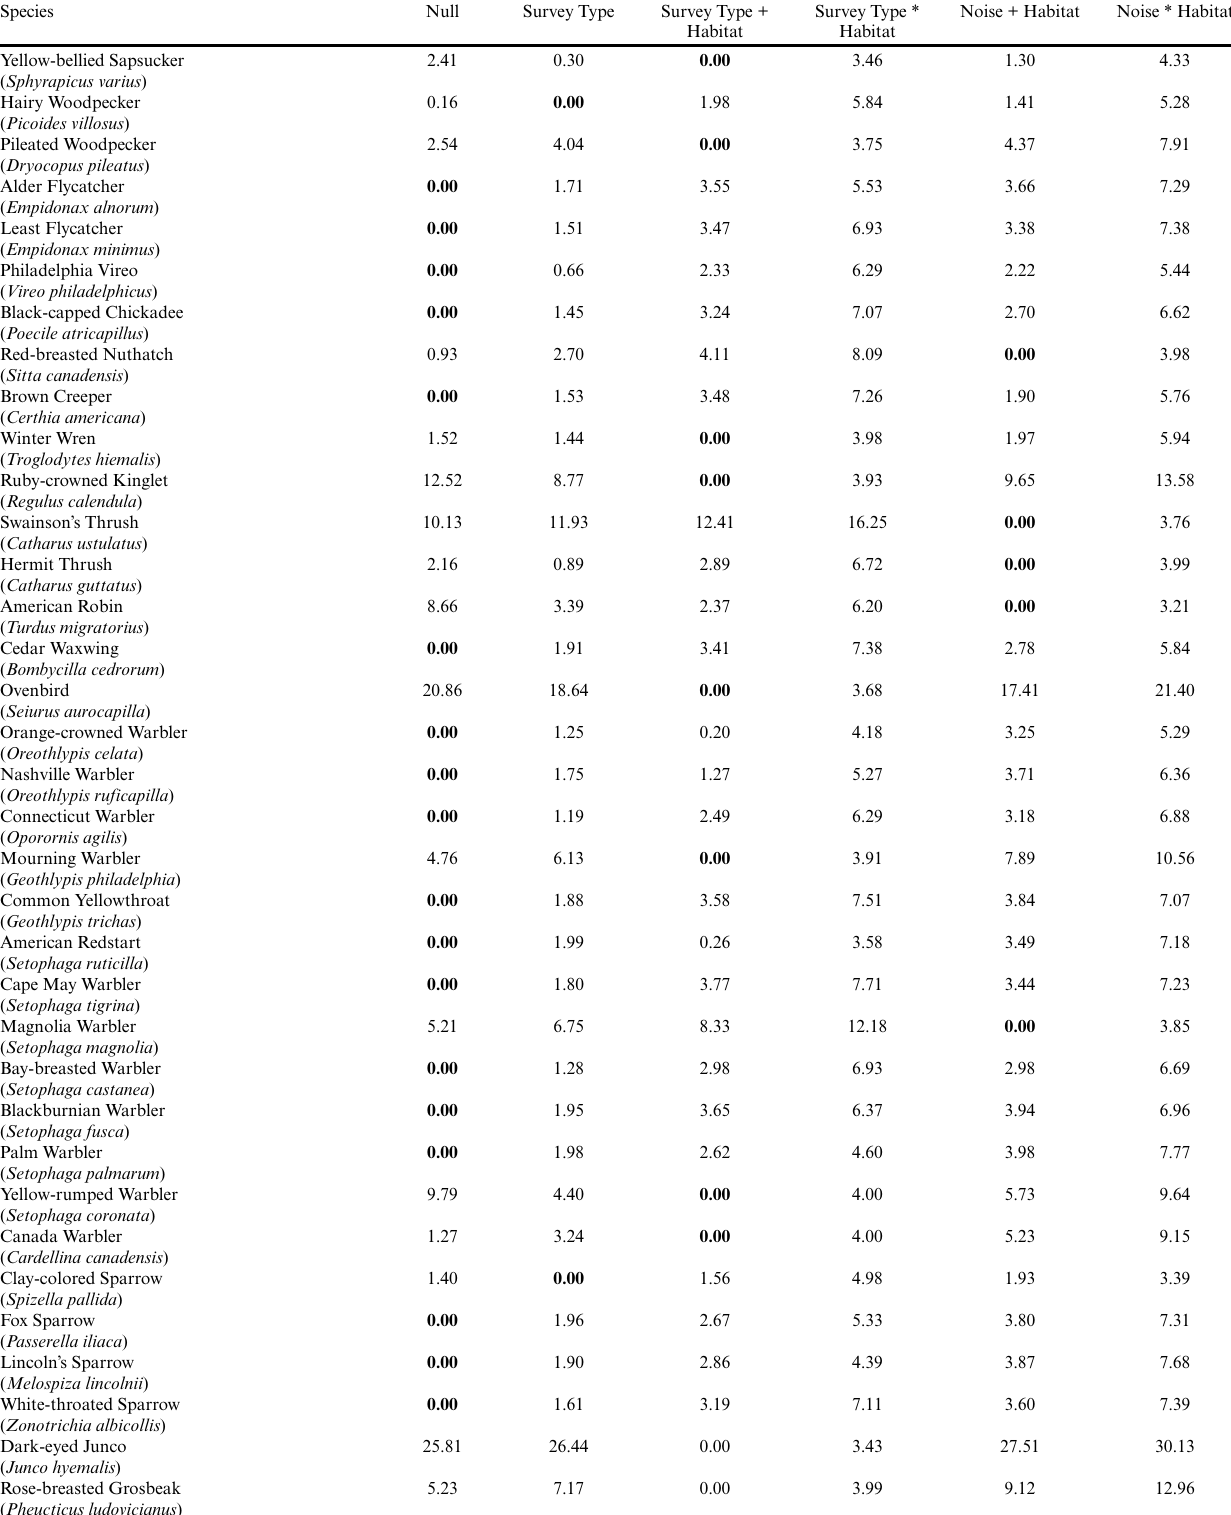
Table 2 . Model selection based on Akaike’s Information Criterion (AIC) for Poisson generalized linear mixed effects models examining variation in counts of 35 species of boreal forest birds. Presented are Δ AIC values that rank models relative to the model with the lowest AIC value, with the lowest value (i.e., 0) representing the most parsimonious